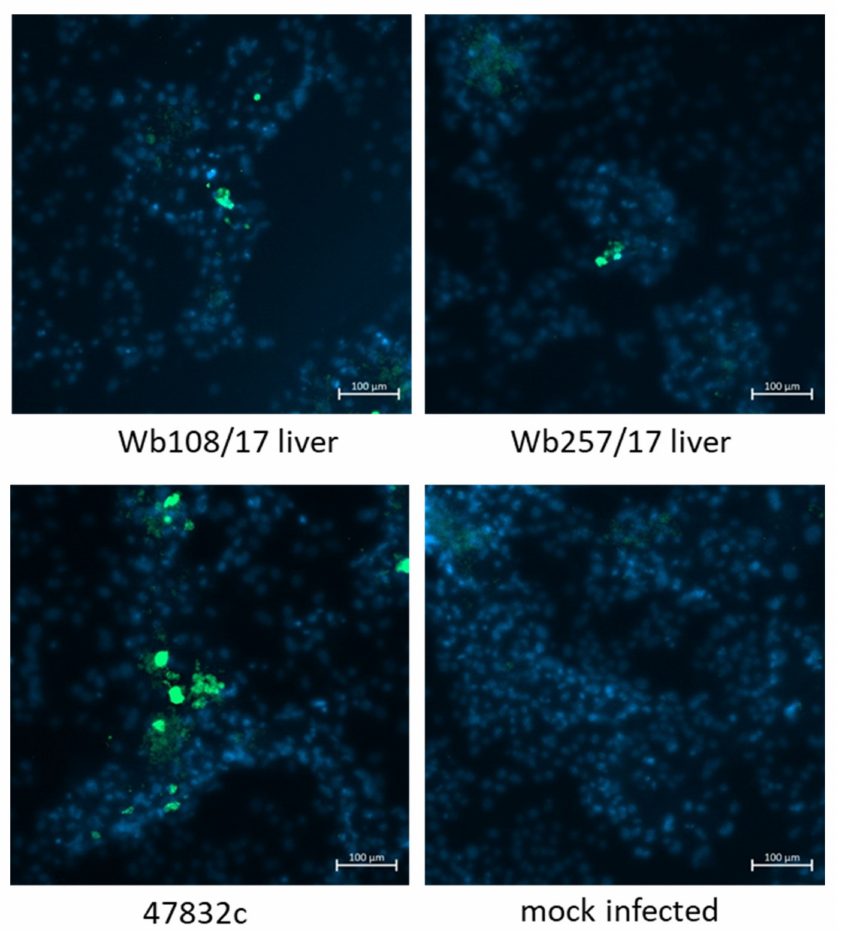
Figure 5. Immunofluorescence analysis of PLC/PRF/5 cells 2 weeks after infection with cell culture supernatants from 49 d p.i. of the 2nd passage. Staining was done using an anti-HEV capsid protein-specific antiserum (green staining). Cell nuclei were stained with DAPI (blue staining). Scale bar: 100 µ